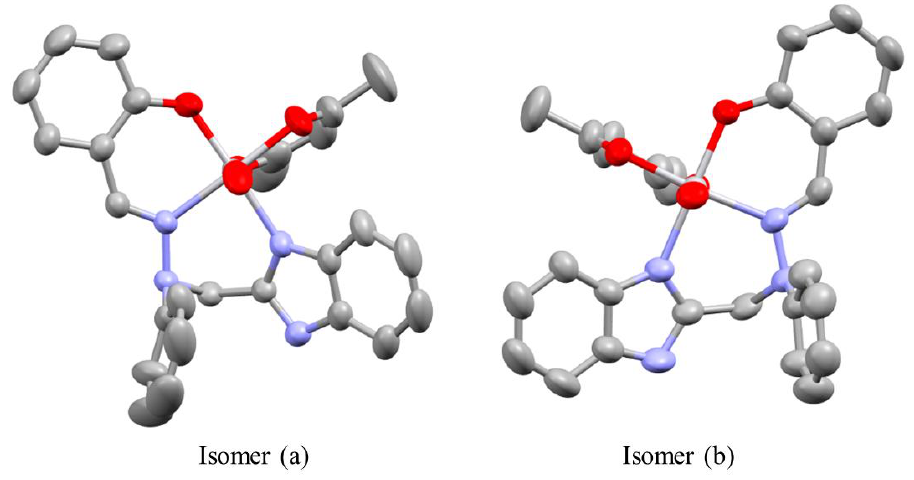
Figure 7. View of enantiomers ( a and b ) present in the asymmetric unit of the crystal packing in complex 1 , drawn as mirror images. Non-hydrogen atoms were drawn using 50% probability ellipsoids. Hydrogen atoms were omitted for simplicity. The drawings were made with the mercury 3.8 program.